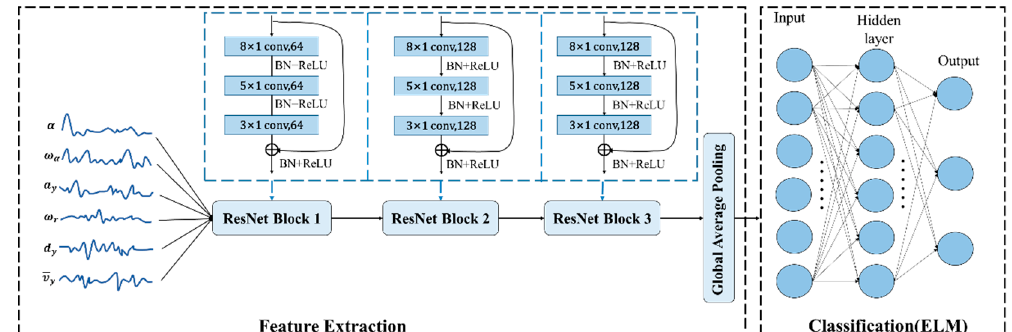
Figure 6. The Extreme Learning Residual Network (ELR-Net) architecture for driver behaviours classification. This architecture consists of six time-series inputs, three residual blocks, Global Average Pooling (GAP) layer, and Extreme Learning Machine (ELM). Each residual block consists of three convolutions, the lengths of the convolution filters are 8, 5, and 3. The number of filters for three residual blocks is 64, 128, and 128 respectively.